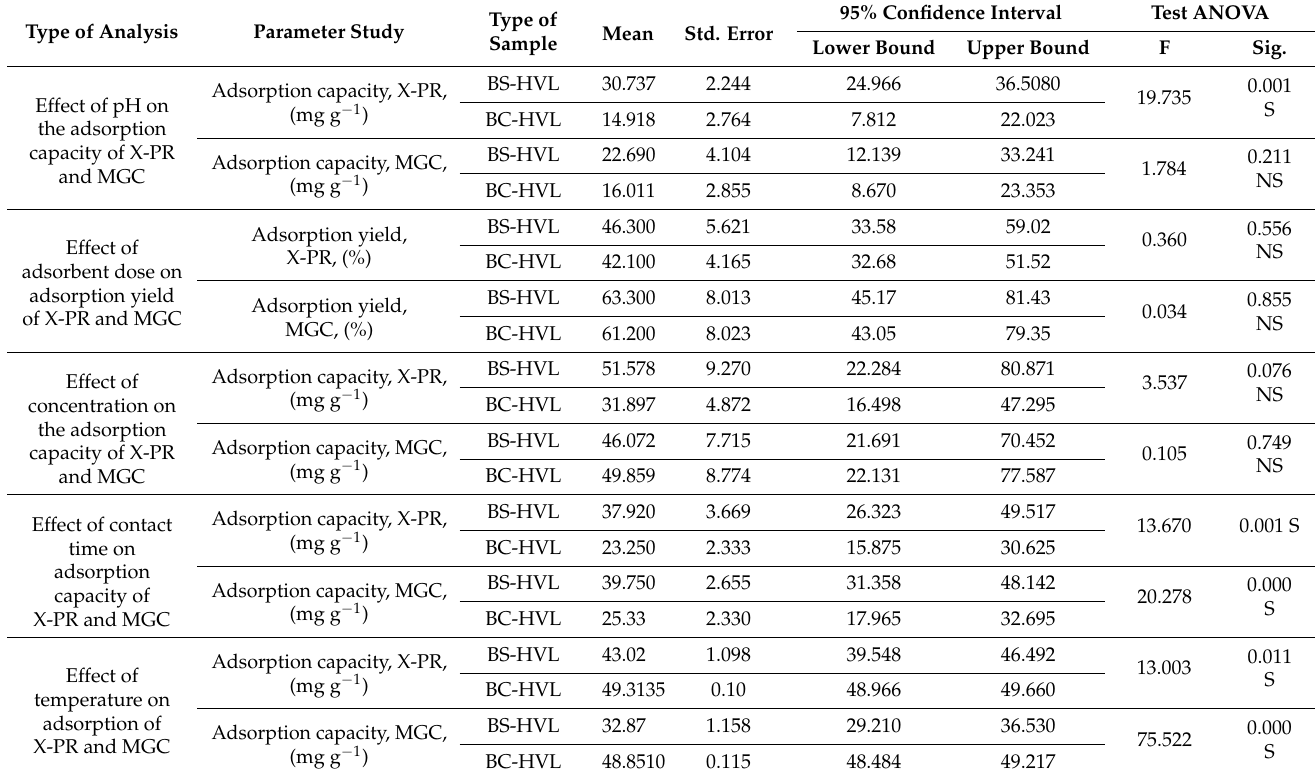
Table 3. Analysis of variance (F-test) of the effects on the adsorption of X-PR and MGC in the two biomaterials BS-HVL and BC-HVL.